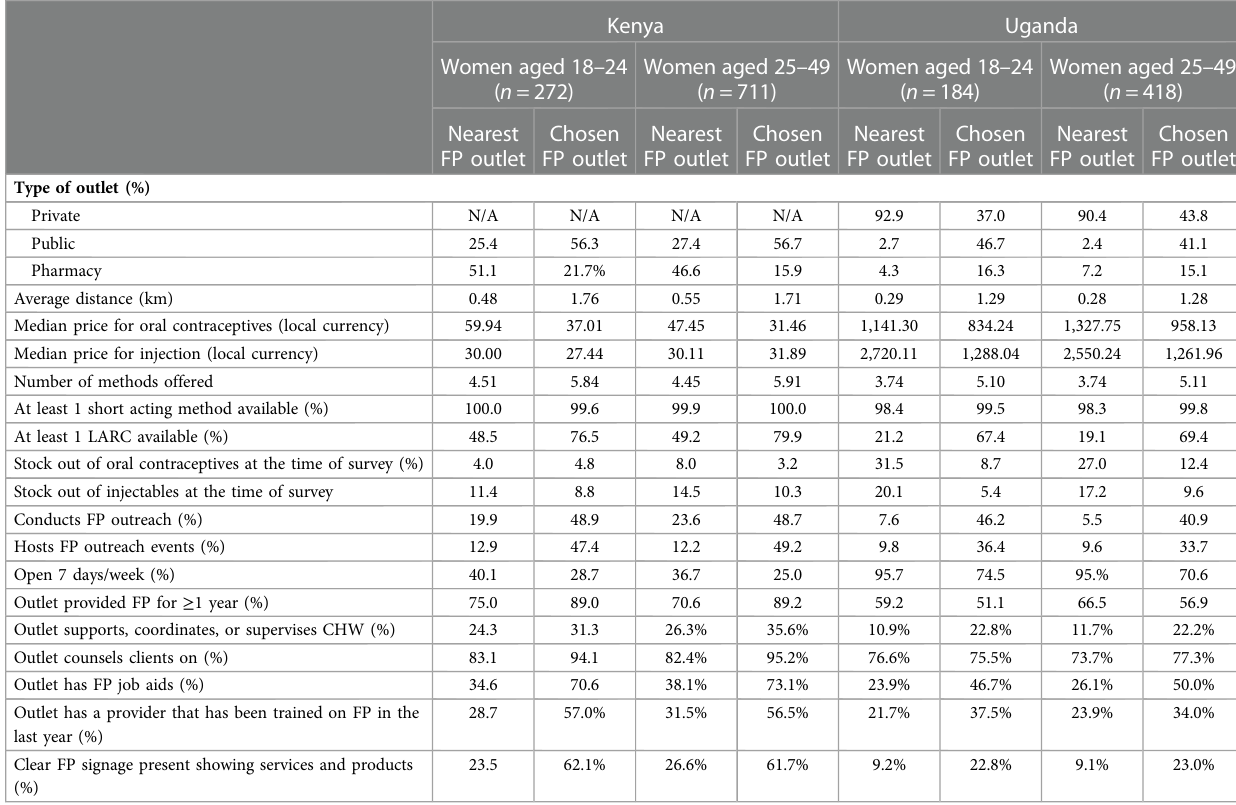
TABLE 3 Characteristics of nearest and chosen facilities in CM4FP audit in Kenya and